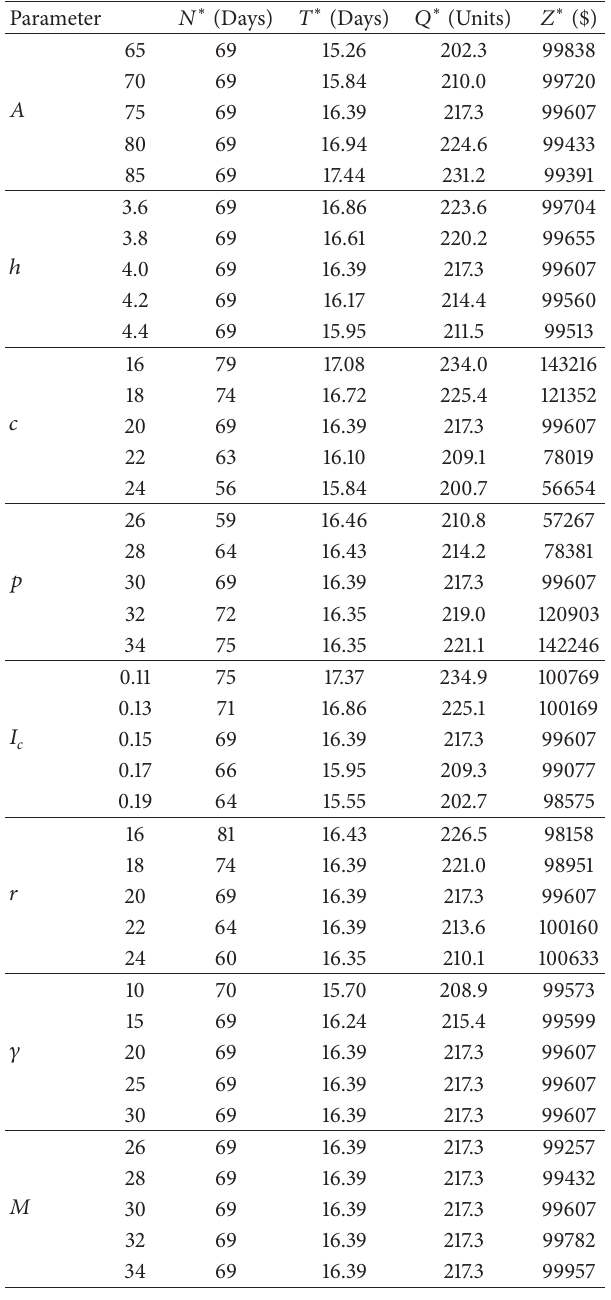
Table 1: Sensitive analysis of Example 13 for parameters 𝐴 , ℎ , 𝑐 , 𝑝 ,